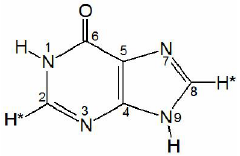
Figure 2. Structure of (2,8- 3